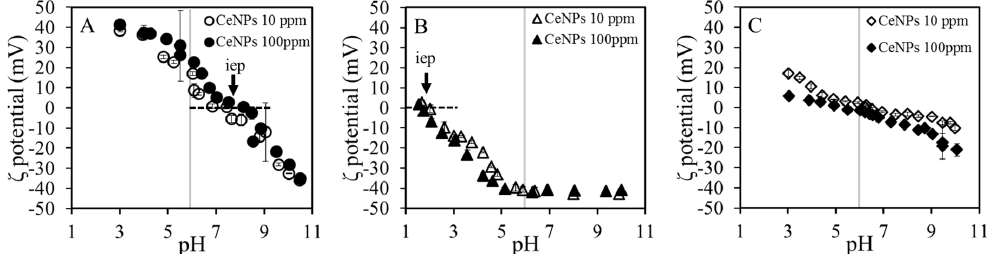
Figure 8. The ζ potential curves of CeNPs under three different conditions: ( A ) control solution; ( B ) inorganic orthophosphate solution; and ( C ) EPS solution. Data for two CeNP concentrations are shown: 10 mg L − 1 (open) and 100 mg L − 1 (closed).